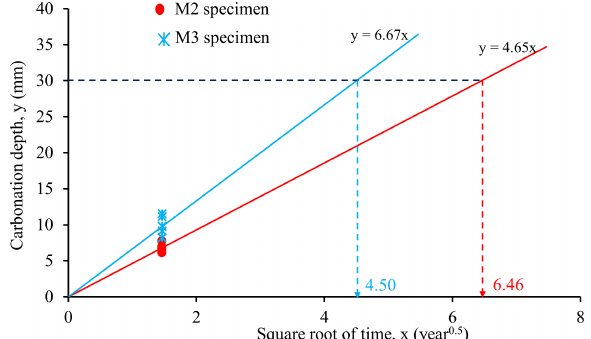
Fig. 9. Carbonation depth of specimens versus square root of time.